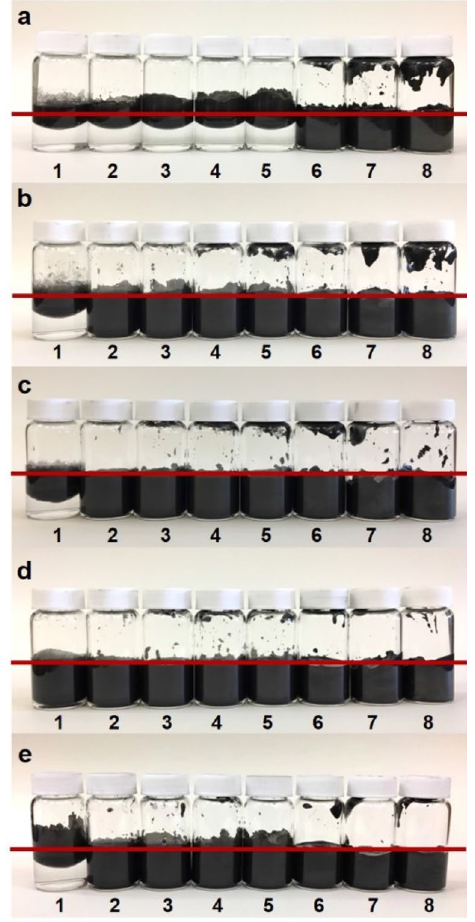
Figure 2. From left to right vails contain increasing concentration of graphite. From vial 1–8 (in g/ml): 0.001, 0.002, 0.003, 0.004, 0.005, 0.010, 0.020, 0.030. The solvent is a 7:3 volume ratio of water and hexadecane (red line indicates the liquid/air interface); ( a ) emulsions immediately after shaking for 40 s; ( b ) same samples as in a after sitting for 24 h followed by a second 40 s shaking; ( c ) emulsions from ( b ) after standing for an additional